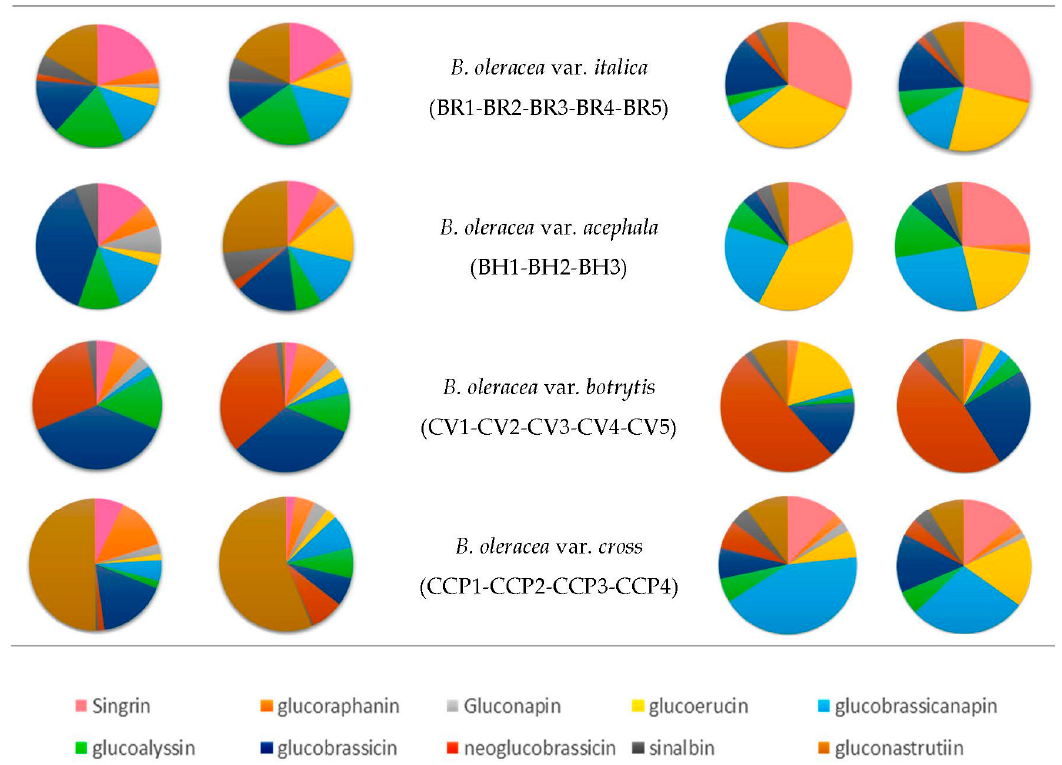
Figure 1. Chemotaxonomy of different glucosinolates found in the tested accessions in relation to water stress, grouping them by varieties (roots and leaves). The indolic glucosinolate accounted for the major component in cauliflower (Brassica oleracea var. botrytis) with 66.0% of the total amount. Glucobrassicin represents 37.5% of the total glucosinolates; in relation to water stress, a decrease to 32.4% was observed while the neoglucobrassicin increased from 28.7% to 34.0%. In our study, the aliphatic glucosin- olates represent 31.0% of the total GLSs in cauliflower, while the aromatic glucosinolates were found in a very low percentage.